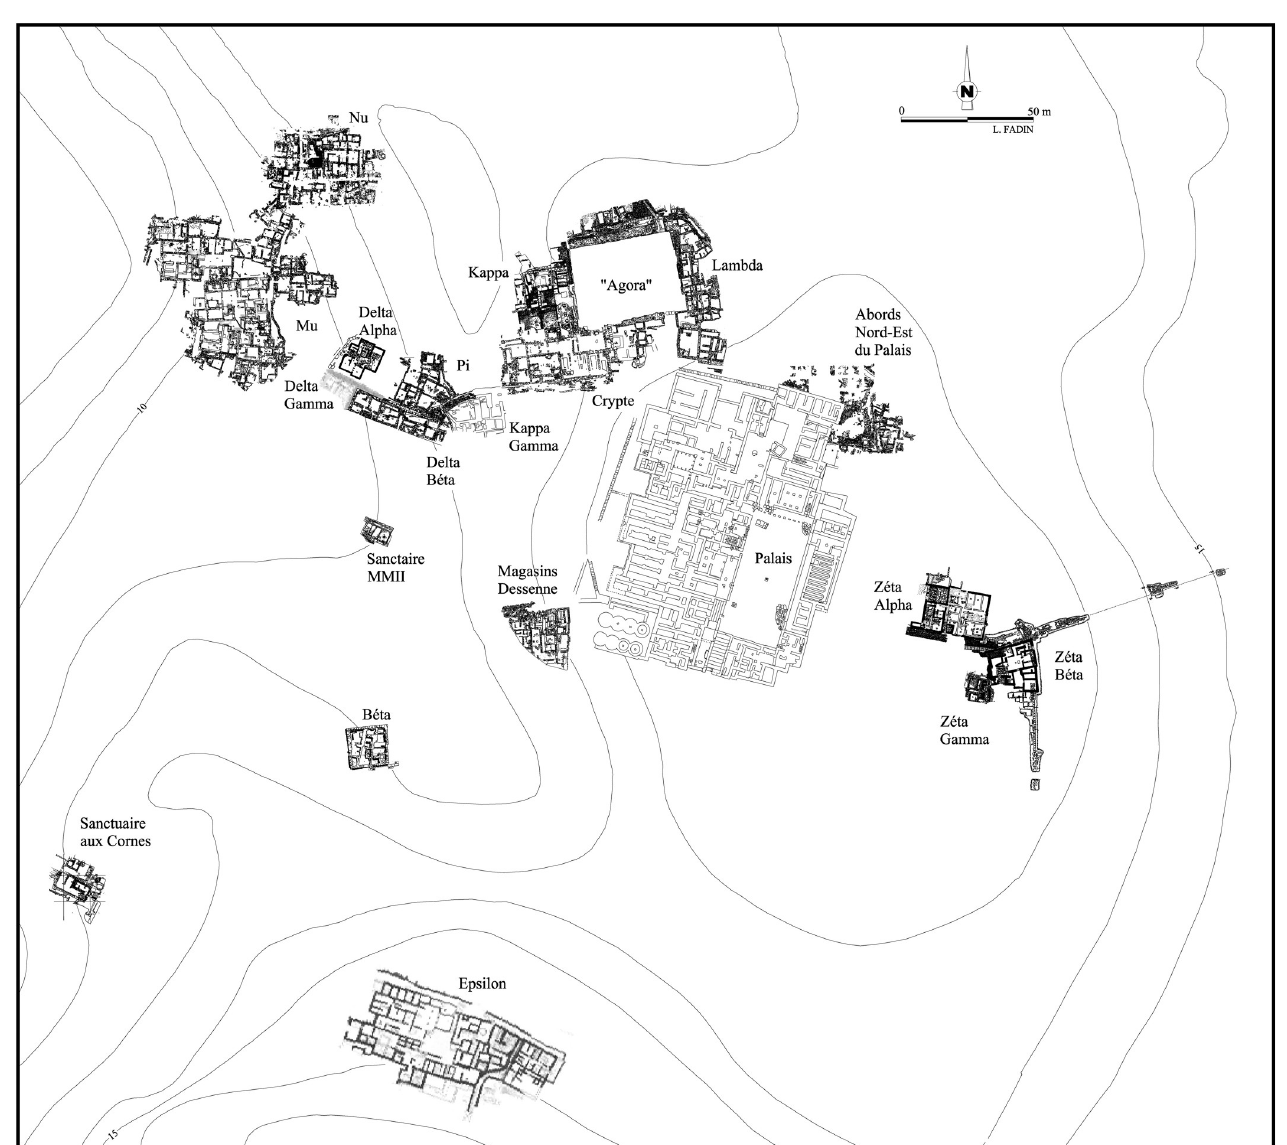
Fig 3. Plan of the Malia excavations. Plan reproduced with permission of the E ´ cole Franc¸aise d’Ath è nes.